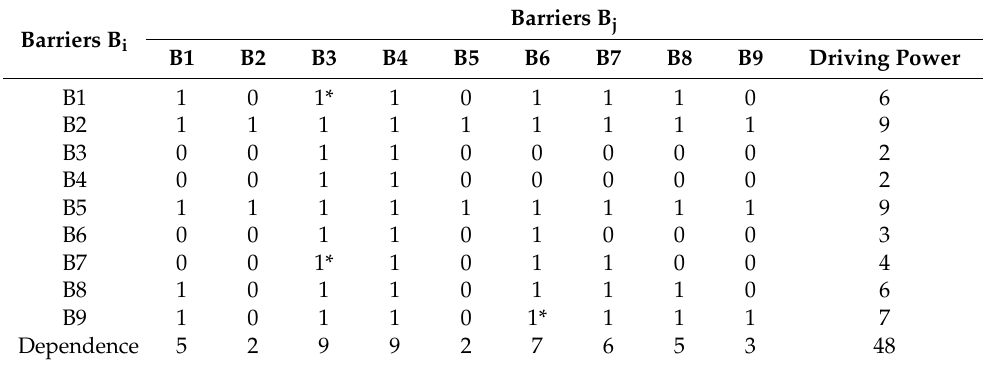
Table 7. FMR of the barriers of socio-political sustainability. Barriers B